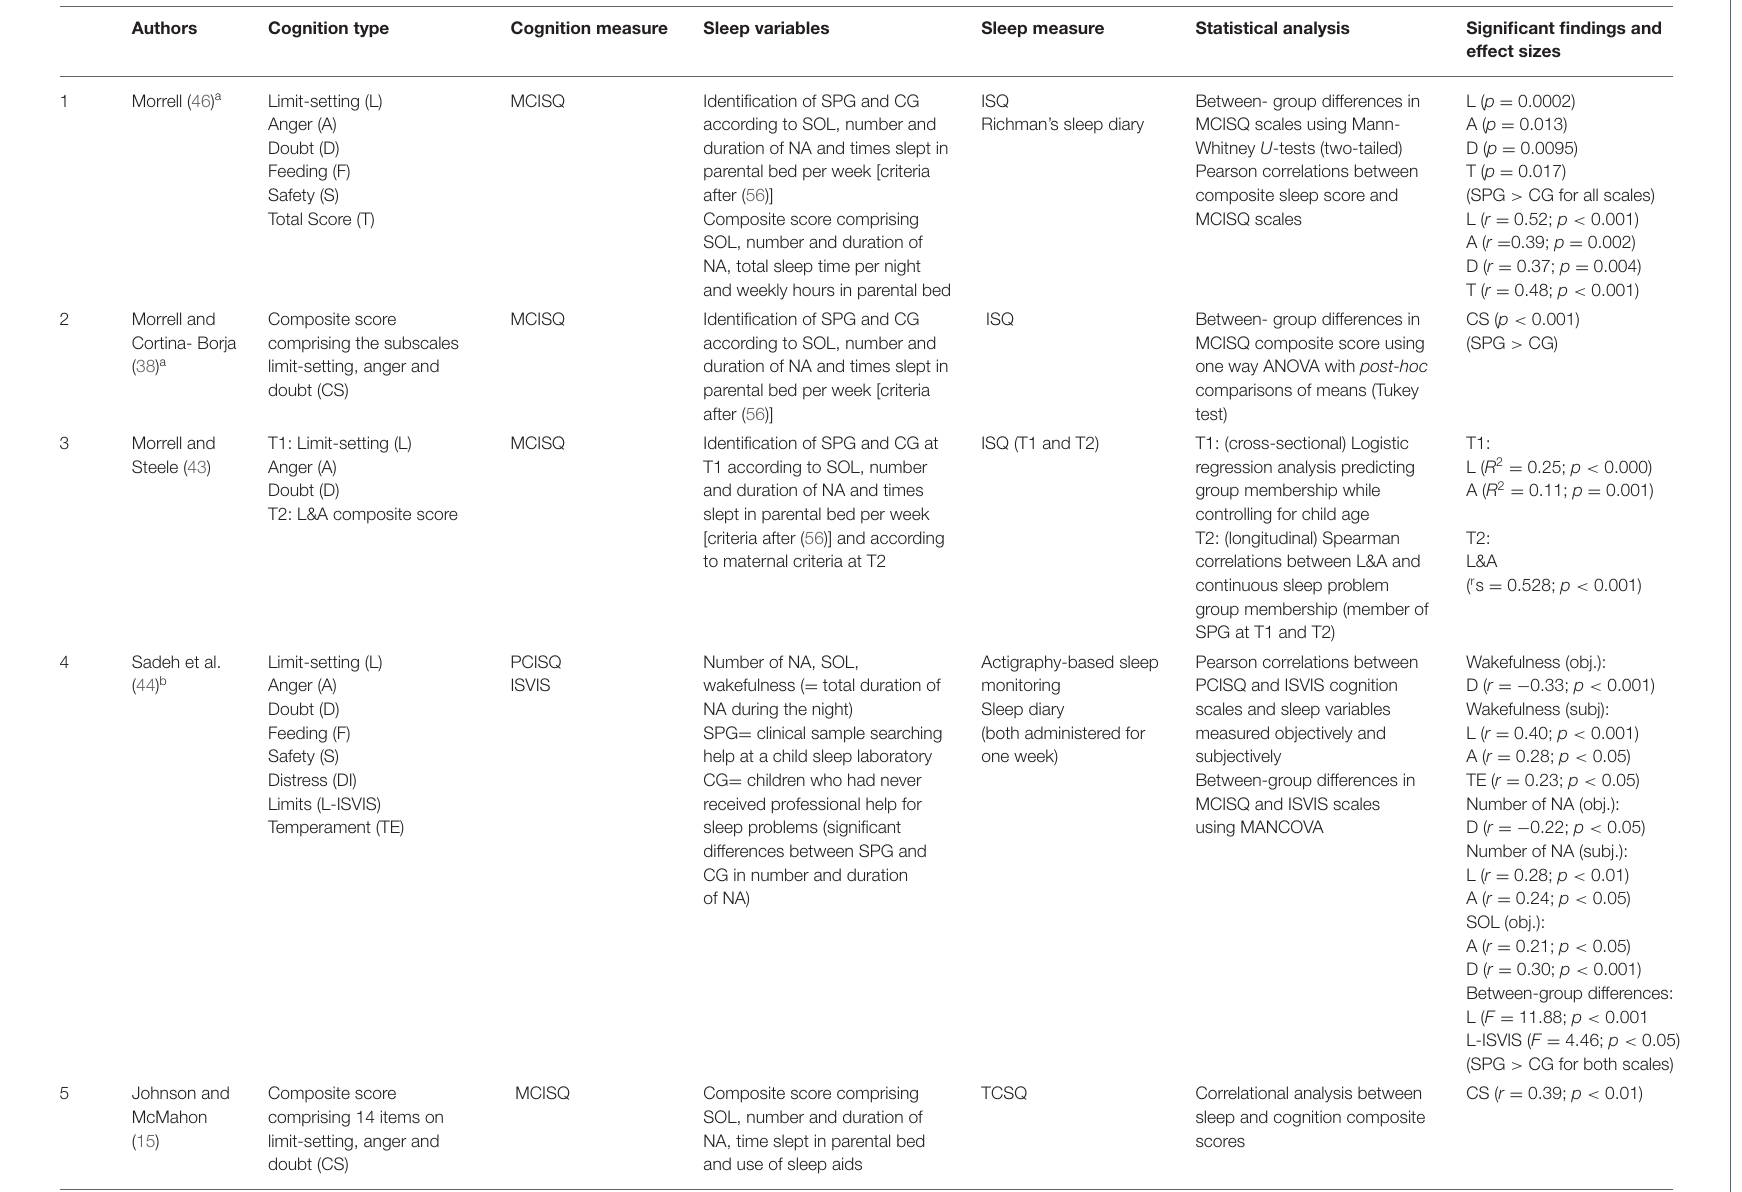
TABLE 1 | Studies on sleep related cognitions in parents and offspring